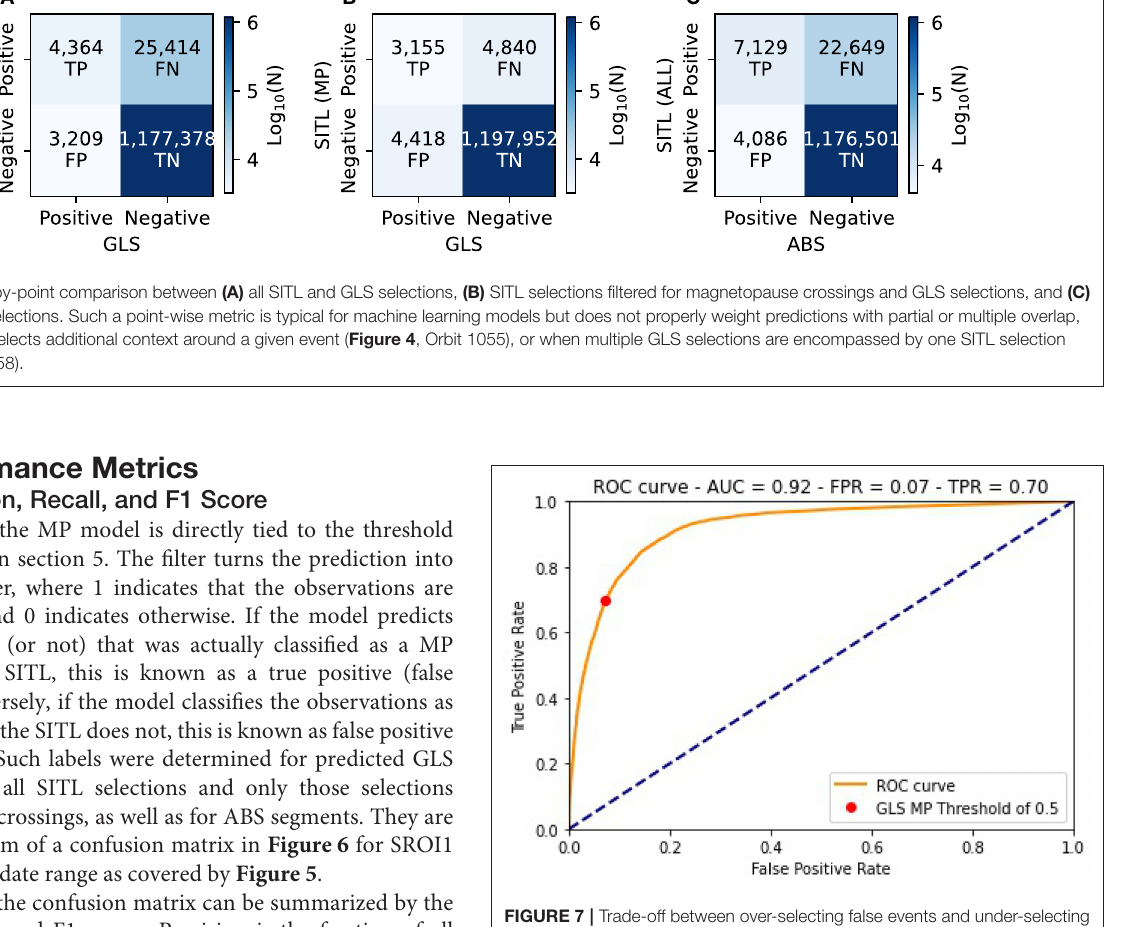
FIGURE 7 | Trade-off between over-selecting false events and under-selecting true events. For MMS, electron diffusion regions are rare and difficult to impossible to observe with the SITL data, so the SITL is willing to over-select by choosing all MP crossings, but they still has to contend with telemetry restrictions. The choice of thresholds for the GLS MP model tries to emulate this